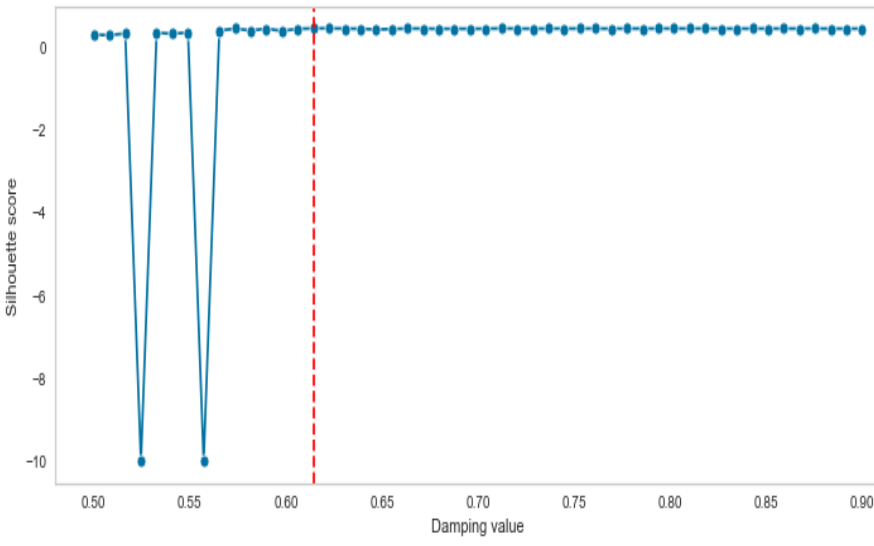
Figure 19. Silhouette score of different dumping values for AP clustering model.